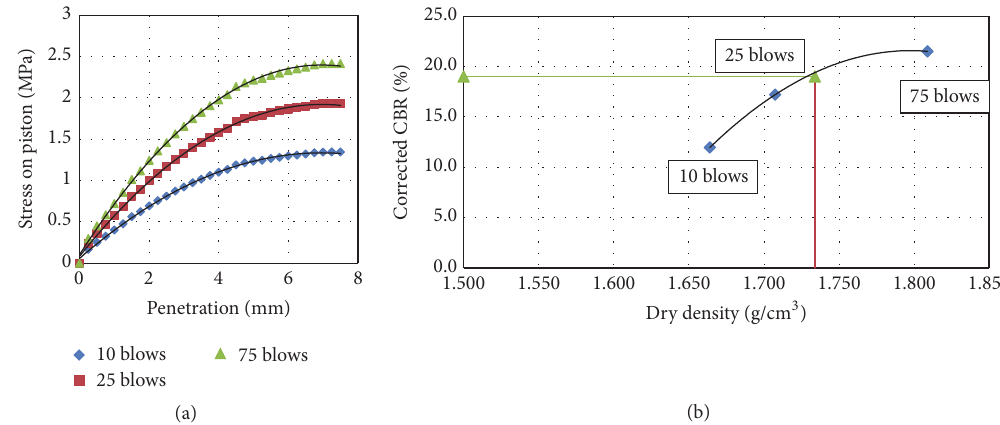
Figure 11: (a) Relationship between resistance and penetration for soil with 20% FSSA additives. (b) CBR value for soil with 20% FSSA additives.